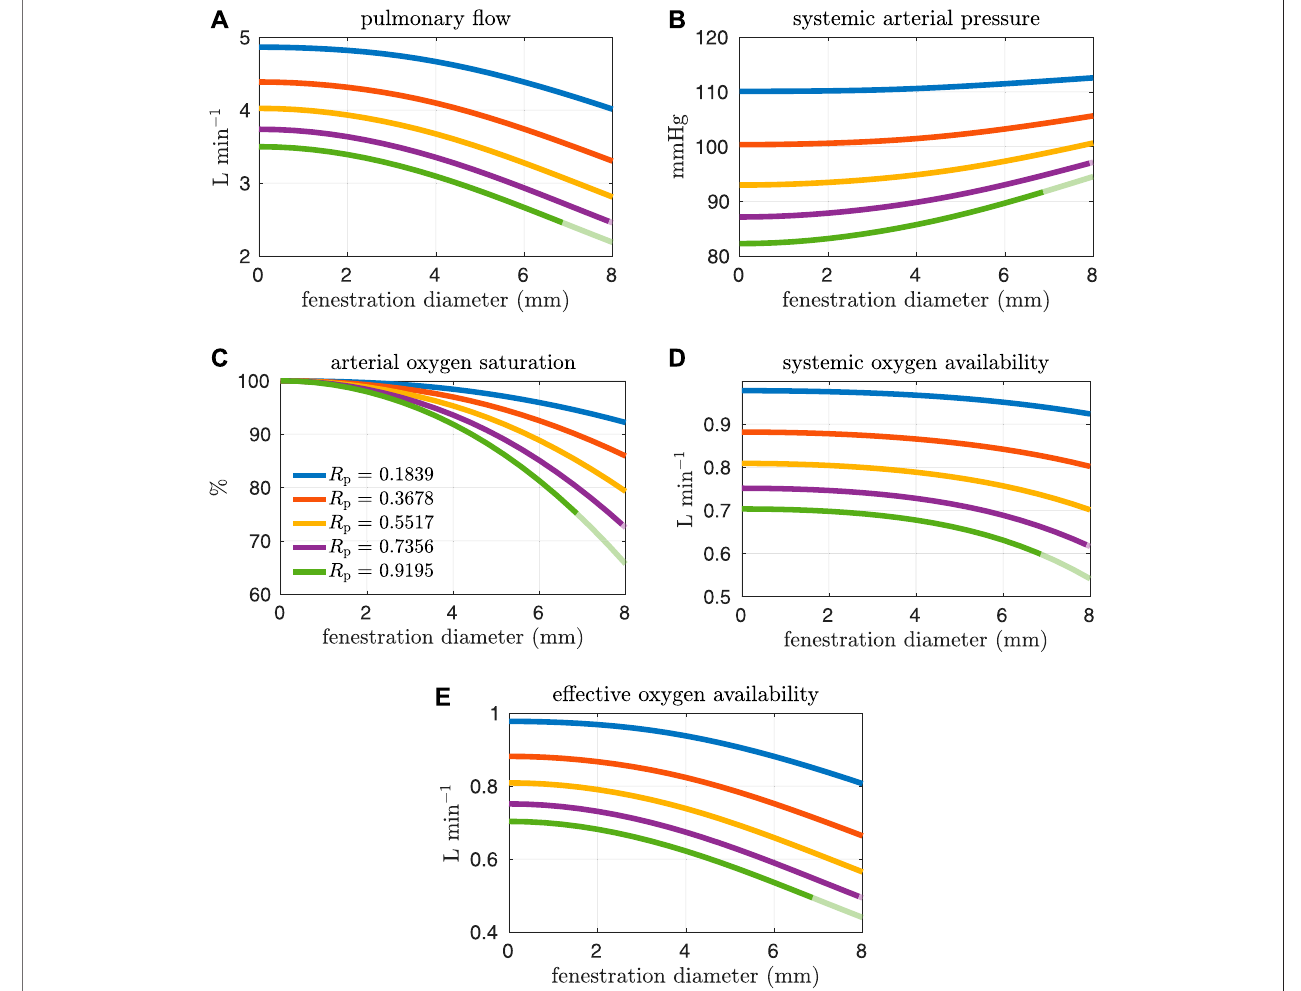
FIGURE 5 | Results corresponding to oxygen consumption equal to − 0.3236 L min − 1 . Pulmonary resistance values R p centered around our baseline value are considered. Mean values for different hemodynamic and oxygen transport variables are plotted as functions of the fenestration diameter. Note that both the systemic oxygen availability and effective oxygen availability curves are monotonically decreasing as the fenestration diameter increases. (A) pulmonary fl ow, (B) systemic arterial pressure, (C) arterial oxygen saturation, (D) systemic oxygen availability, (E) effective oxygen availability.